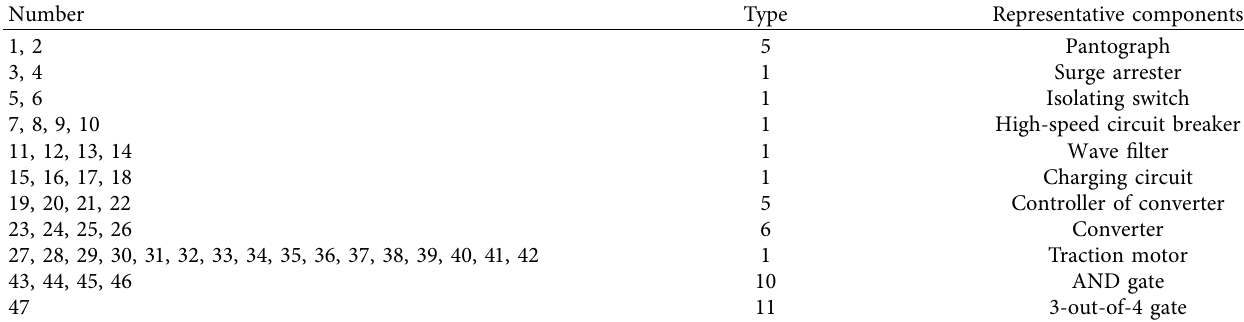
Table 2: Data of operators for the